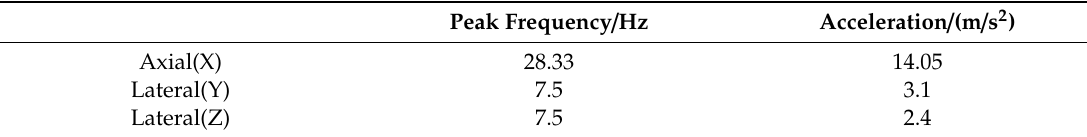
Figure 2. Satellite branch structure. Table 1. Peak frequencies and acceleration